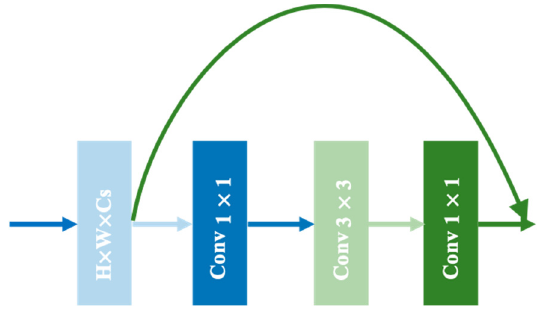
Figure 4. Component awareness module.